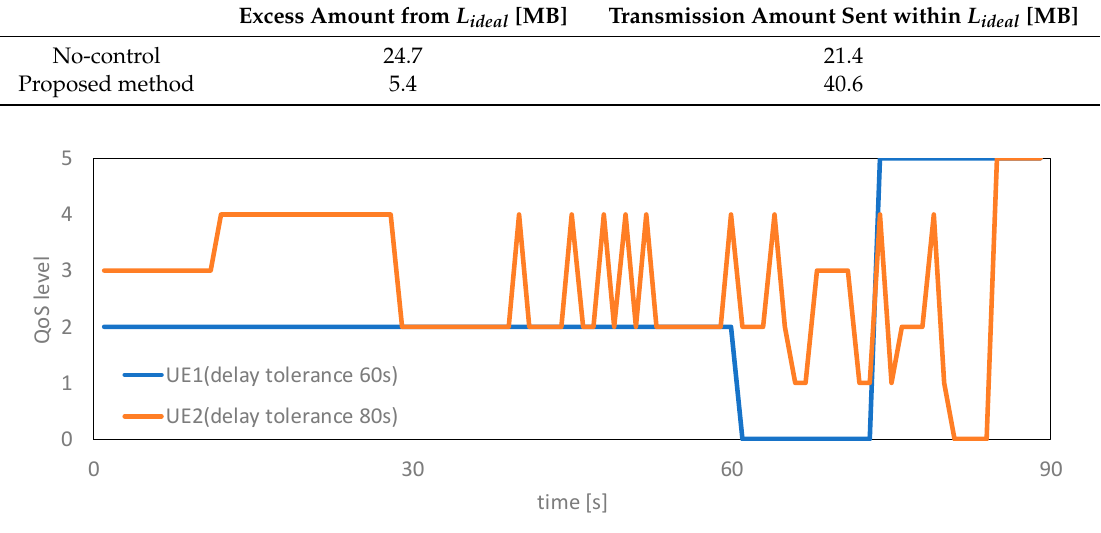
Figure 6. QoS level assignment.